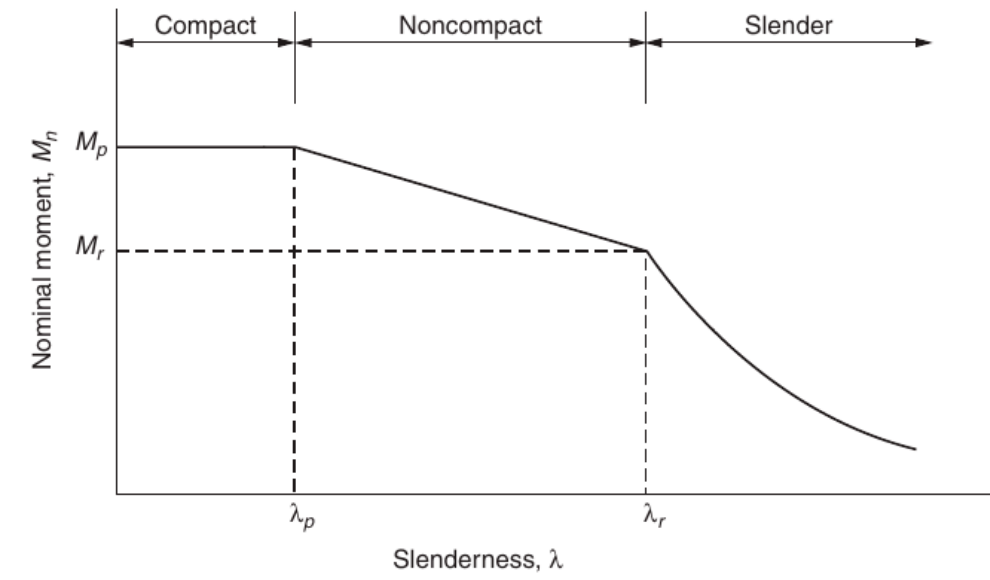
Figure 4. Classification of beam sections according to their slenderness [1] .